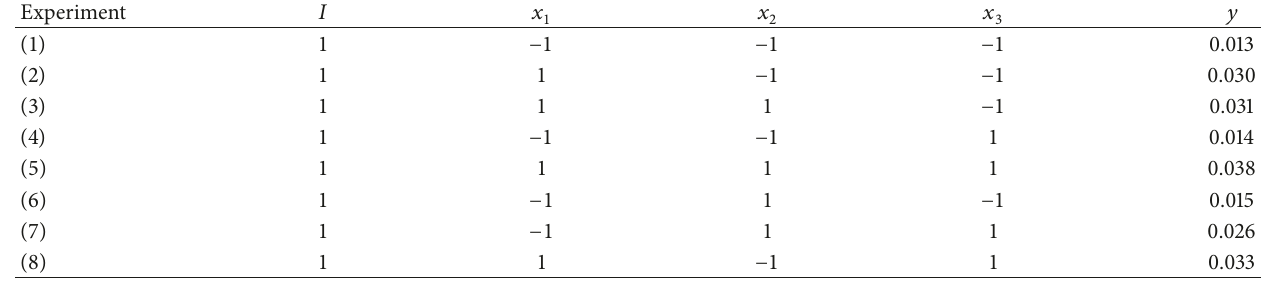
Table 4: Experimental design matrix.